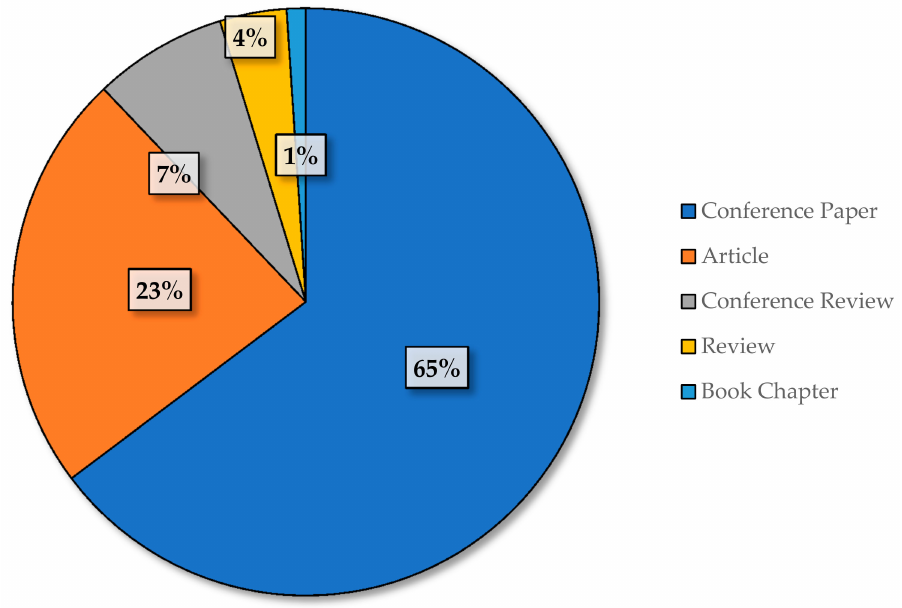
Figure 9. Publications in the intersection of the DT and safety research fields by document